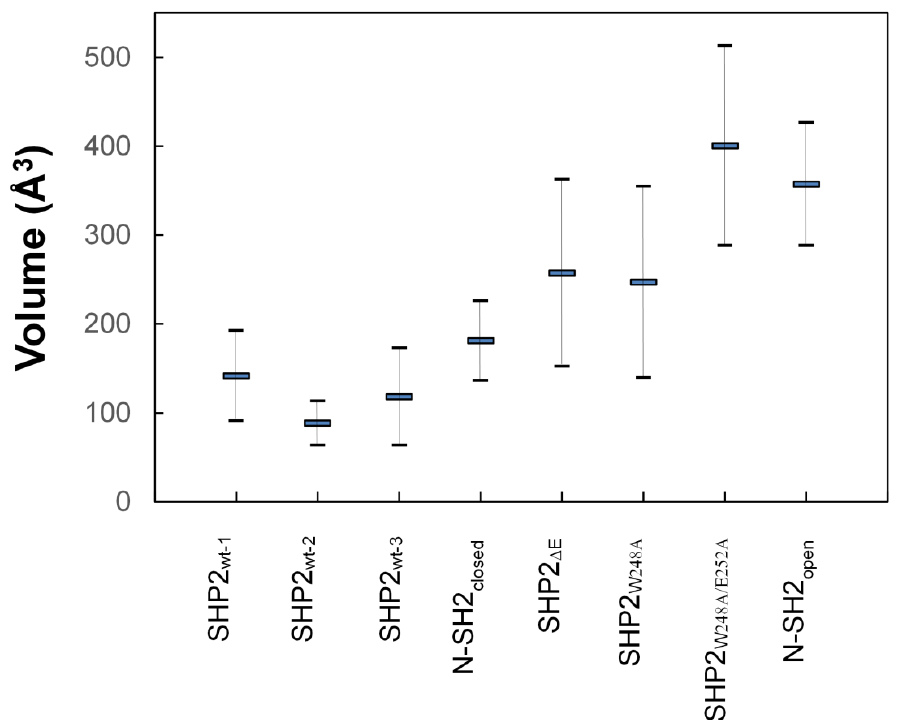
Figure 3. Average volumes of the groove in the pY peptide-binding region of the N-SH2 domain calculated in the MD simulations of SHP2-wt (triplicate MD runs 1–3), SHP2-ΔE6, SHP2-W248A, SHP2-W248A/E252A, N-SH2 closed , and N-SH2 open (from snapshots collected every 1 ns in the 3–30 ns time interval).